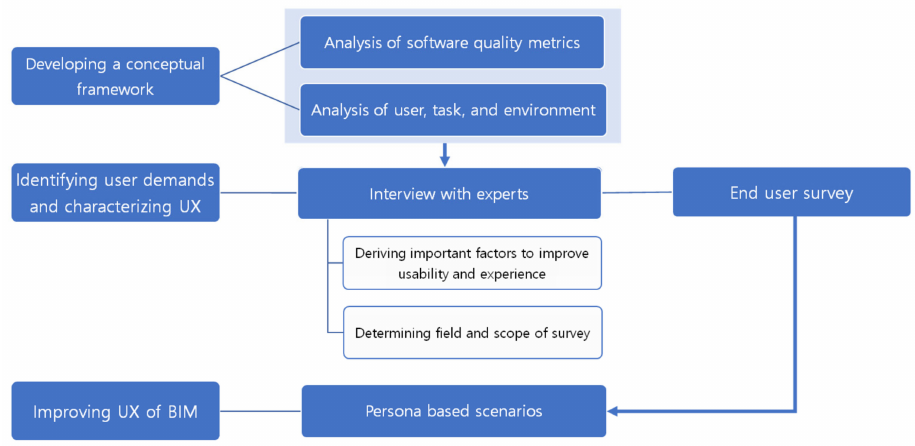
Figure 1. Flow chart of overall